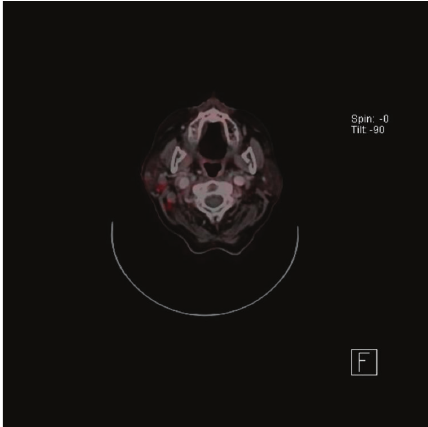
Figure 1: PET/CT: pathologic enhancement in the right parotideal